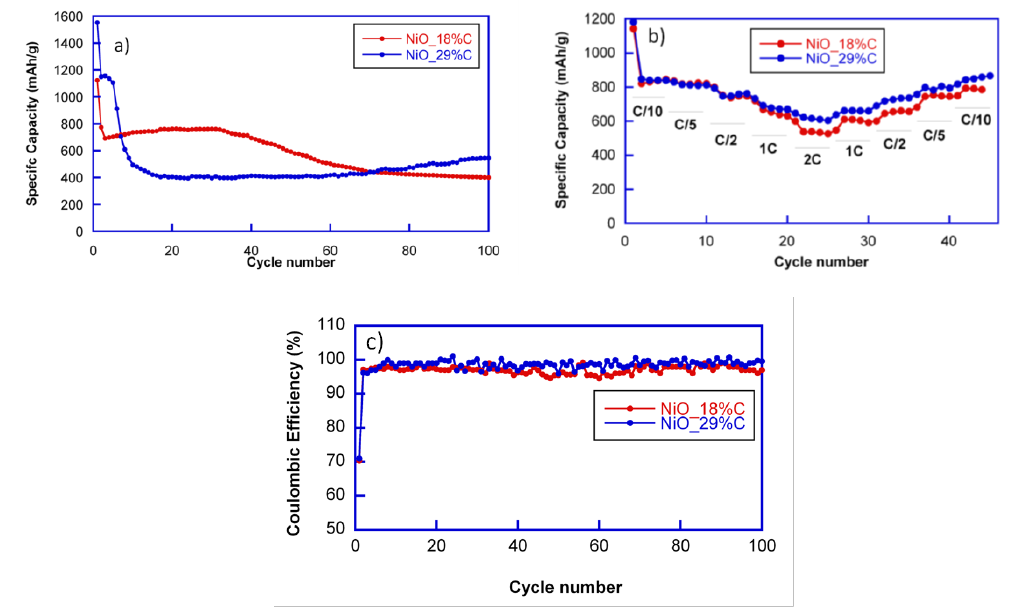
Figure 5. ( a ) Cyclability of NiO_18%C, and NiO_29%C samples at 1C rate and ( b ) rate discharge capabilities for NiO_18%C and NiO_29%C samples, and ( c ) coulombic